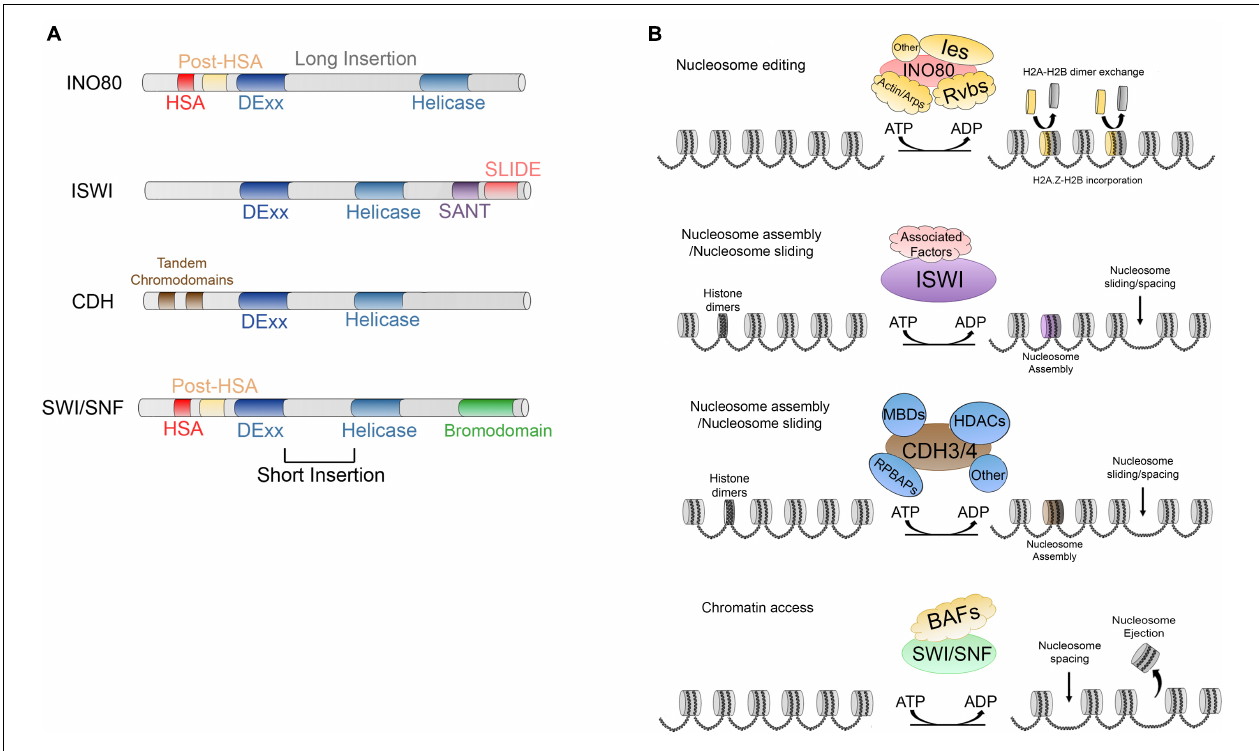
FIGURE 3 | (A) Main characteristics and domains of INO80, IWSI, CHD, and SWI/SNF families. (B) ATP dependent activities carried out by; INO80, which is responsible of nucleosome editing by exchanging H2A-H2B and H2A.Z-H2B dimers; ISWI and CDH are involved in nucleosome maturation and nucleosome assembly; additionally, ISWI and CDH members are involved in nucleosome spacing and sliding; SWI/SNF members trigger chromatin access through nucleosome spacing, nucleosome ejection as well as dimer